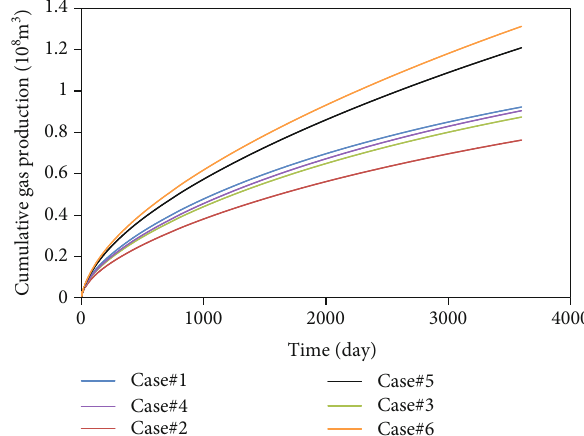
Figure 8: Cumulative production considering the in fl uence of di ff erent physical transport